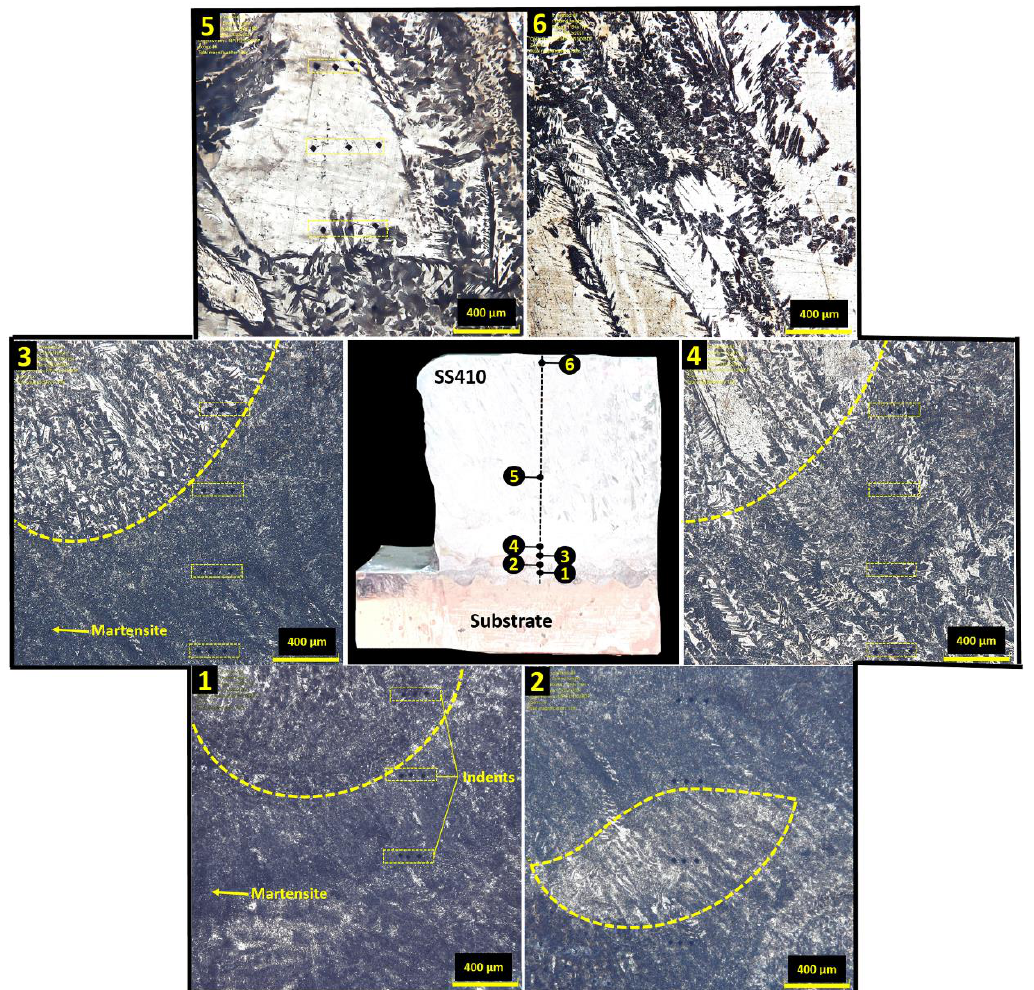
Figure 14. The optical microscope images along the build height of chemically etched SS410